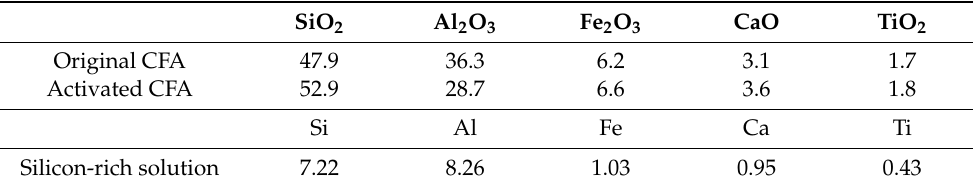
Table 1. Chemical compositions of coal fly ash before and after the activation (wt.%) and of silicon-rich solution